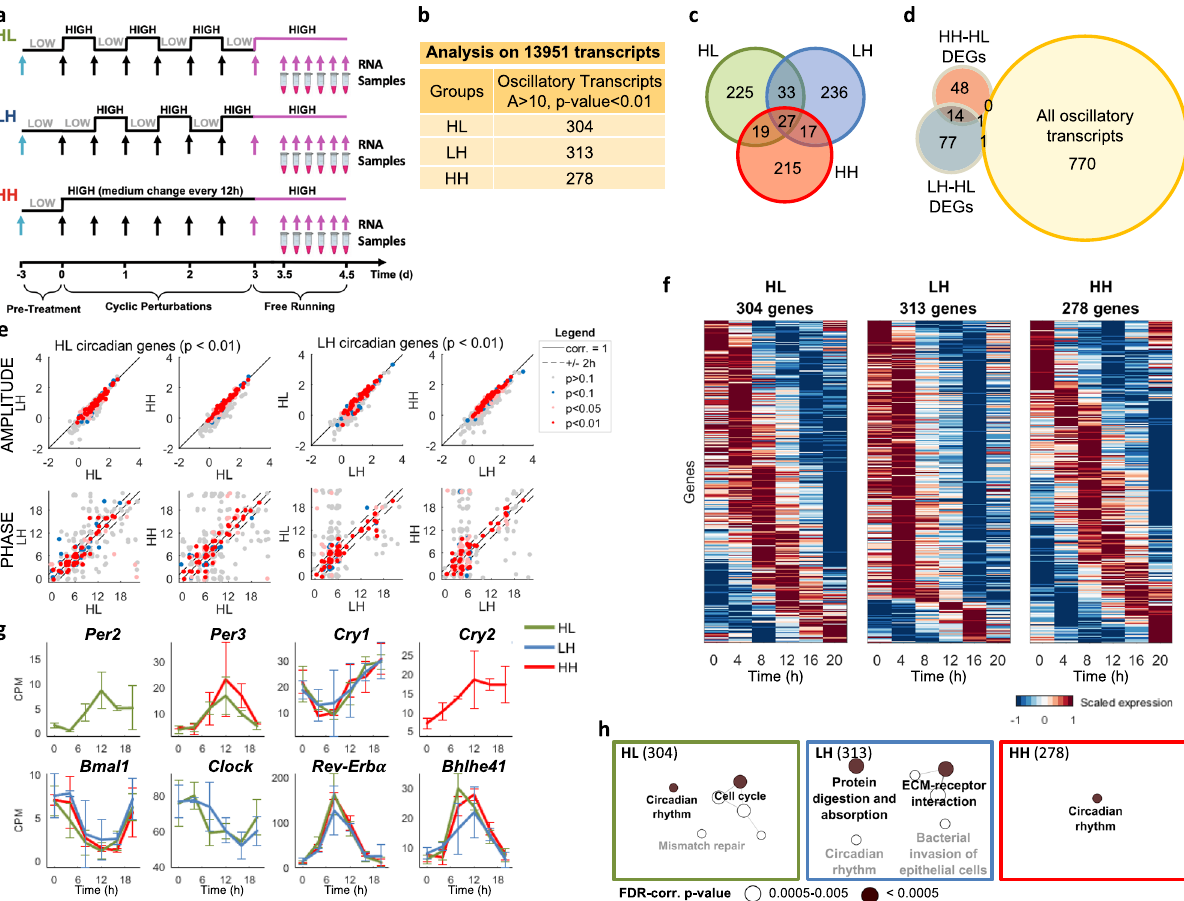
Fig. 4 The circadian transcriptome is reprogrammed by cyclic metabolic patterns. a Schematic representation of feeding-fasting (HL), fasting-feeding (LH), and ad libitum feeding-like (HH) conditions imposed for 3 days and followed by a FR condition. b Number of circadian genes by JTK analysis, with Amplitude > 10 and P -value < 0.01, both provided by JTK test. c Venn diagram including circadian genes ( P < 0.01 of JTK test) in each condition. d Venn diagram including all circadian genes displayed in c , and HH-HL and LH-HL DEGs. e Correlation of circadian gene amplitude and phase, obtained by JTK algorithm, between pairs of conditions. The indicated P -values refer to the signi fi cance level of circadianity. f Heatmaps of oscillating transcripts ( P < 0.01 of JTK test) under HL, LH, and HH conditions. Genes are ordered by phase. g Expression of core clock genes in the conditions indicated in the legend. Only genes with circadian behavior ( P < 0.01 of JTK test) are shown. Error bar: mean ± st. dev, N = 4 for each condition. h Enrichment analysis results of genes oscillating in HL, LH, and HH conditions within pathways in the KEGG database. Links between categories represent the κ